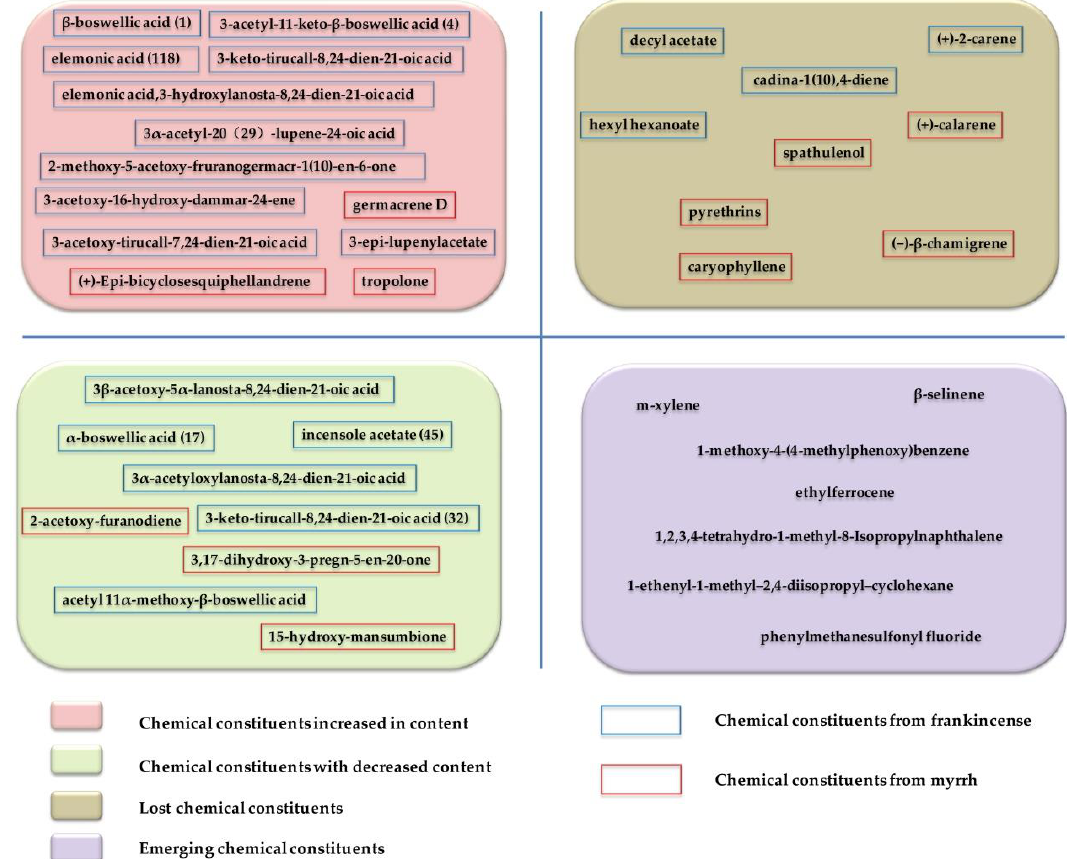
Figure 3. Changes in chemical constituents of frankincense and myrrh before and after compatibility.